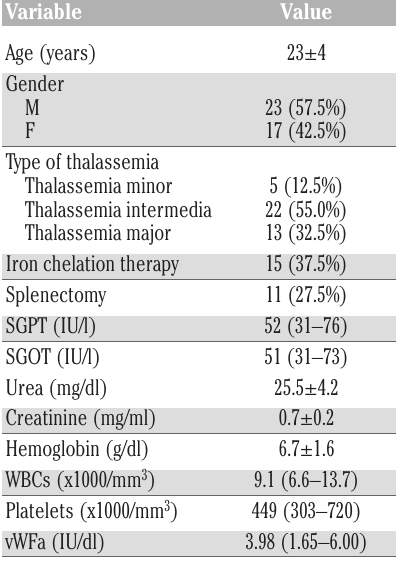
Table 1. Demographic and clinical data of studied thalassemia